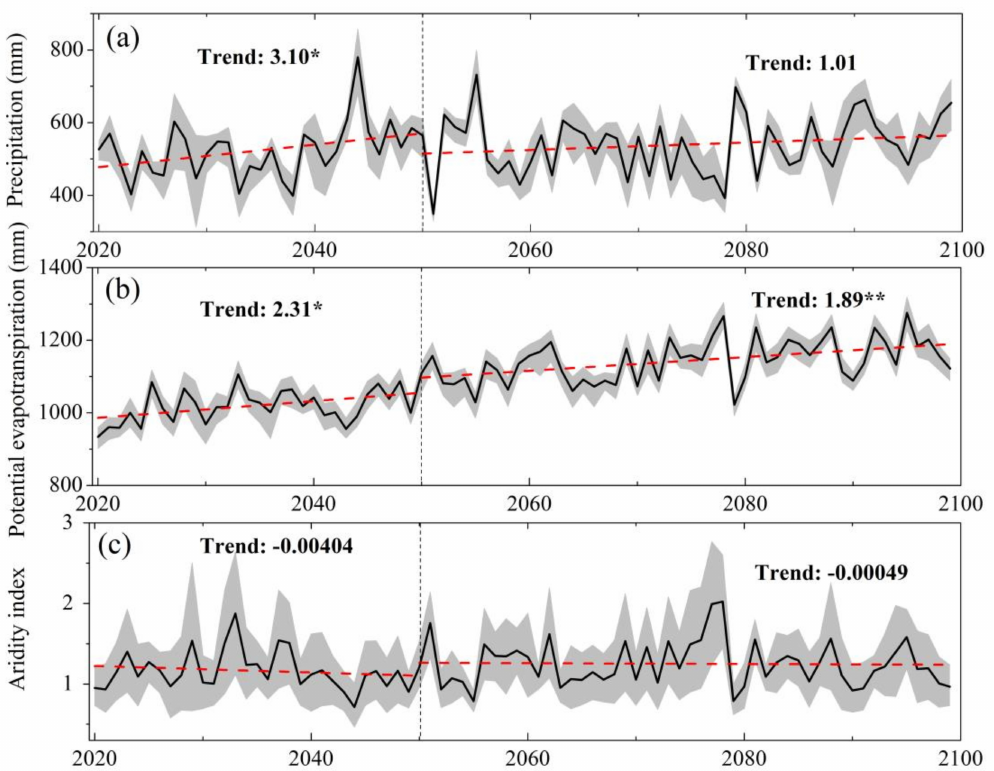
Figure 10. Variation and trends of ( a ) annual precipitation, ( b ) potential evapotranspiration, and ( c ) the aridity index for the 12 watersheds during the periods 2020–2049 and 2050–2099. The red dotted line refers to the trend of climatic variables, and the shaded area refers to the maximum and minimum climatic variables for the 12 watersheds.